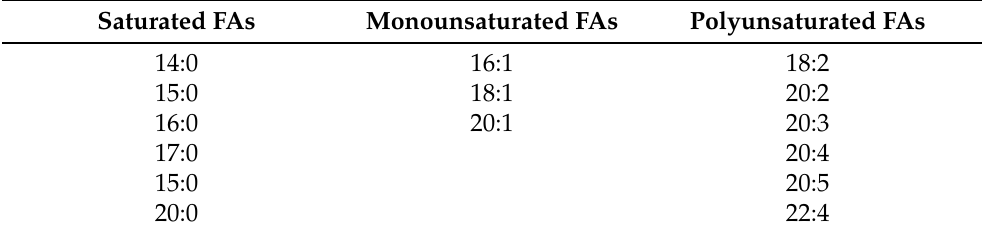
Table A1. LINEX Default Fatty Acids. This list is used when lipids from different classes that only differ in the number of FAs are matched. Users can customize this list for their specific experimental